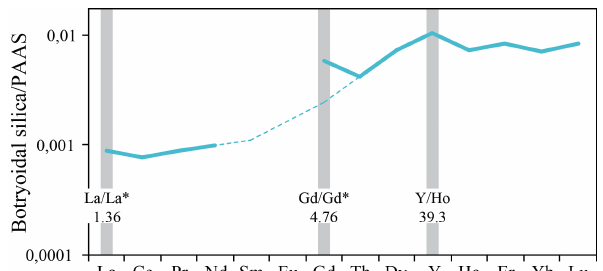
Figure 11. Shale-normalized (PAAS; Taylor and McLennan, 1985) REE pattern for the pure, botryoidal silica sample of Fig. 5a show- ing seawater-like characteristics. Sm and Eu are below the detec- tion limit. We calculate their theoretical concentrations using that of their neighbouring elements (Sm using Pr and Nd, and Eu using Sm and Gd). Because of its anomalous enrichment, a theoretical Gd concentration is also modelled using Tb and Dy. The resulting dotted line helps to highlight the LREE depletion trend typical of oceanic